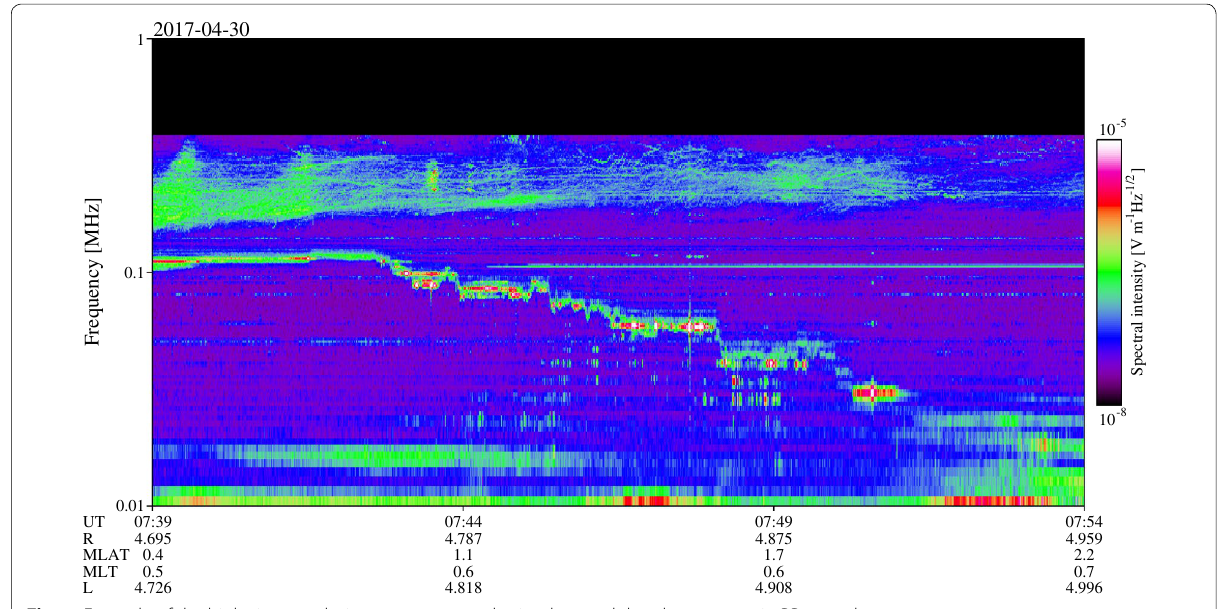
Fig. 5 Example of the high-time resolution spectrogram obtained around the plasmapause in PP-1